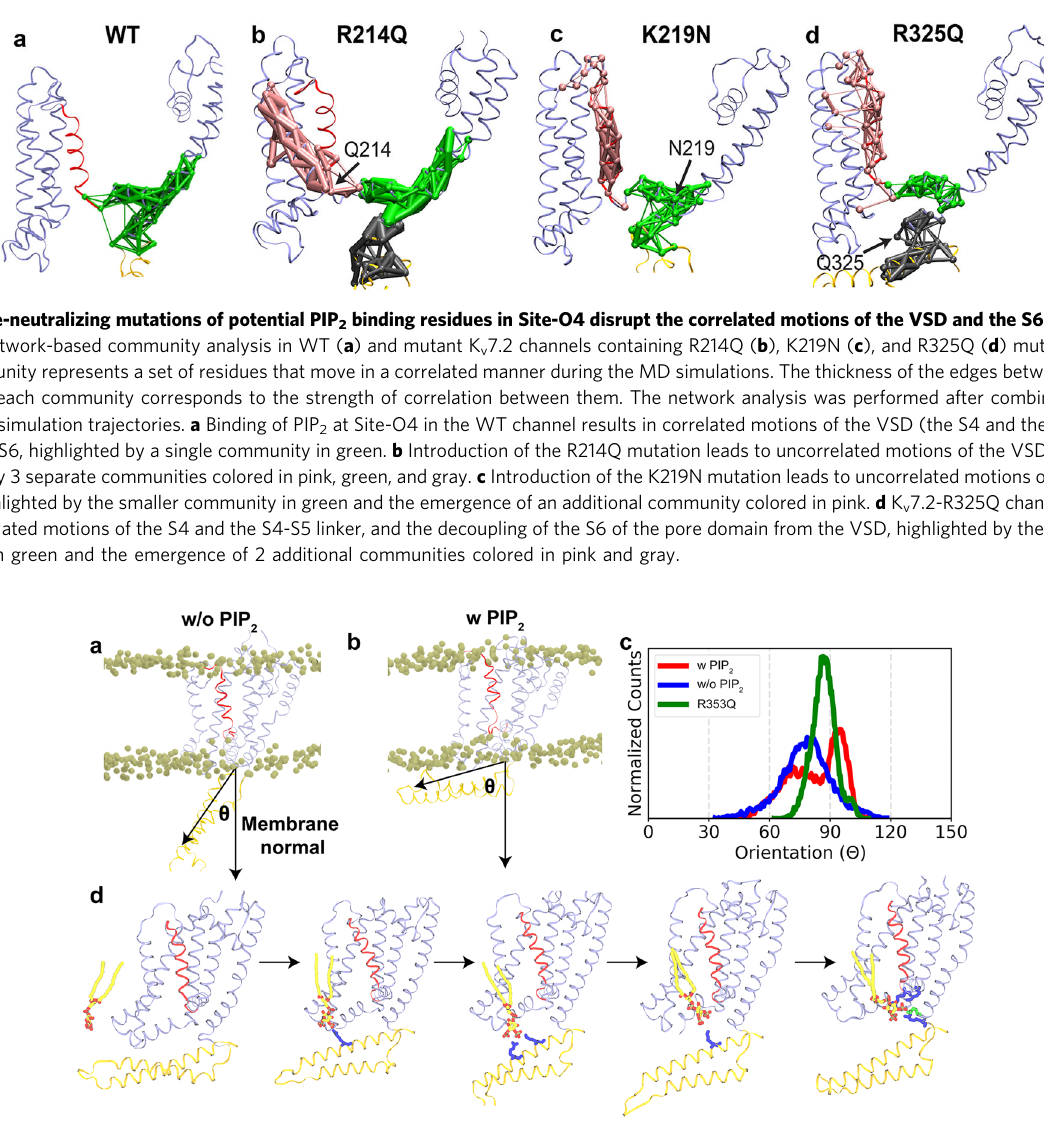
Fig. 7 PIP 2 -mediated conformational changes of helices A and B in open K v 7.2 channel. a Snapshot of a representative K v 7.2 monomer in PIP 2 -free membranes. b Snapshot of a representative K v 7.2 monomer in PIP 2 -containing membranes. c Orientation angle of helices A and B with respect to the membrane normal. The distribution of the orientation angle of helices A and B in WT K v 7.2 channel over the last 200 ns of all the simulations in membranes with (w/) or without (w/o) PIP 2 as well as that of mutant K v 7.2-R353Q channel in membranes with PIP 2 . In PIP 2 -free membranes, the helical pair of the WT channel adopts a largely solvent-exposed conformation. Addition of PIP 2 induces a drastic conformational change in these helices from a solvent-exposed conformation to a bilayer-interacting conformation. However, the R353Q mutation in the AB linker moves the helices closer to a solvent- exposed conformation even in the presence of PIP 2 . d Large-scale conformational change in the cytoplasmic helices provides a pathway for PIP 2 movement along Helix-B to its ultimate localization at Site-O4. All the phosphorus atoms of the bilayer are shown in vdW (van der Waals) representation. K v 7.2 protein is shown in ribbon representation with the S4 in red, helices A and B in brown, and the rest of the protein in ice